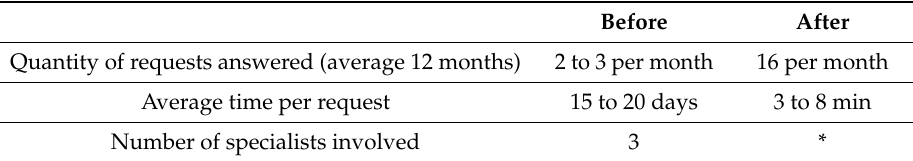
Table 12. Comparison before and after the use of the system (second process).